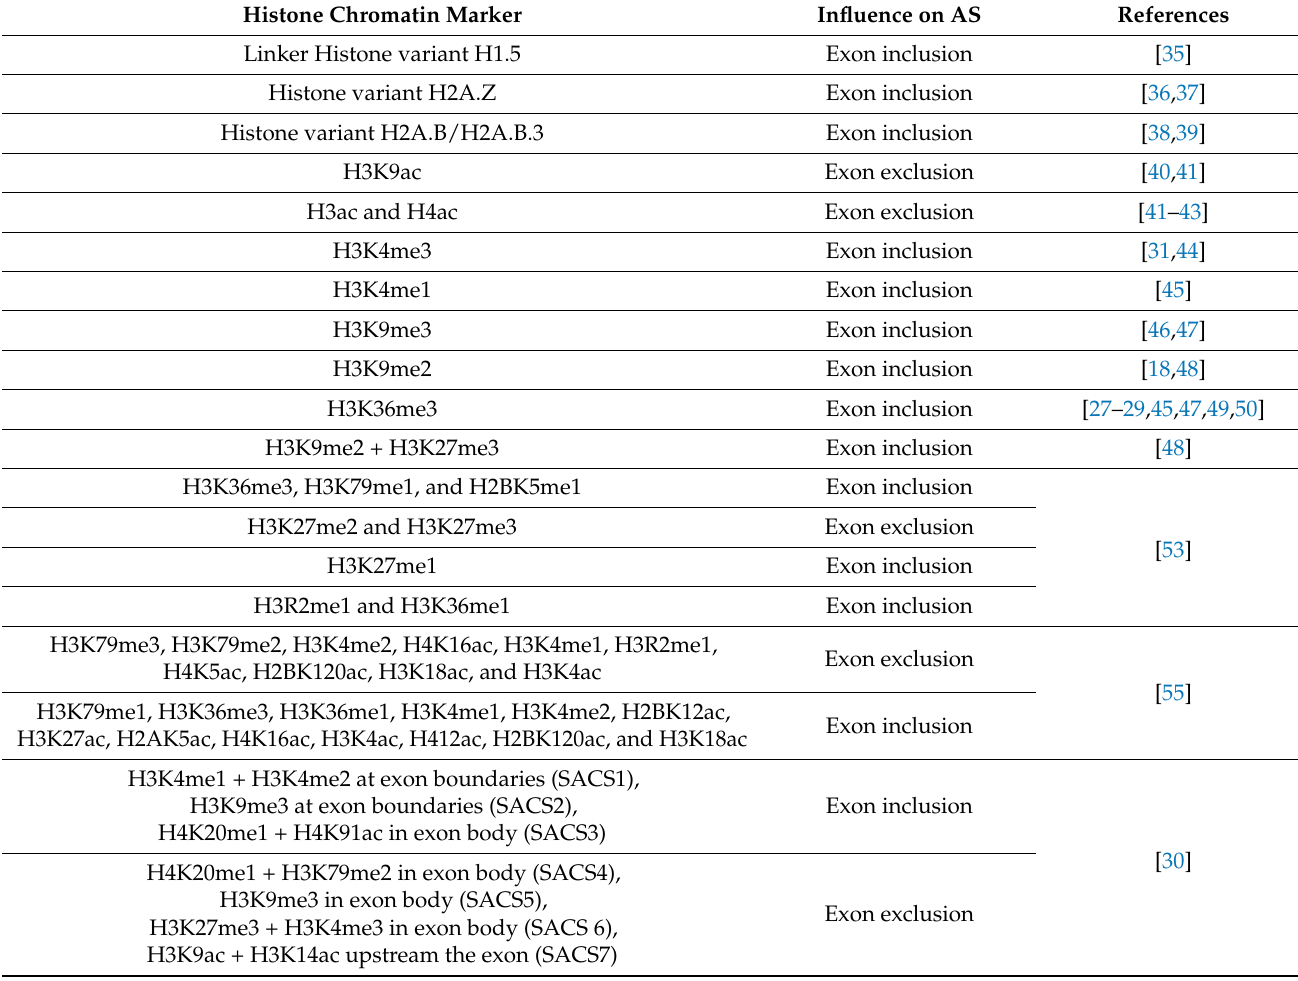
Table 1. An Integrated Model for the Regulation of Alternative Splicing by histone